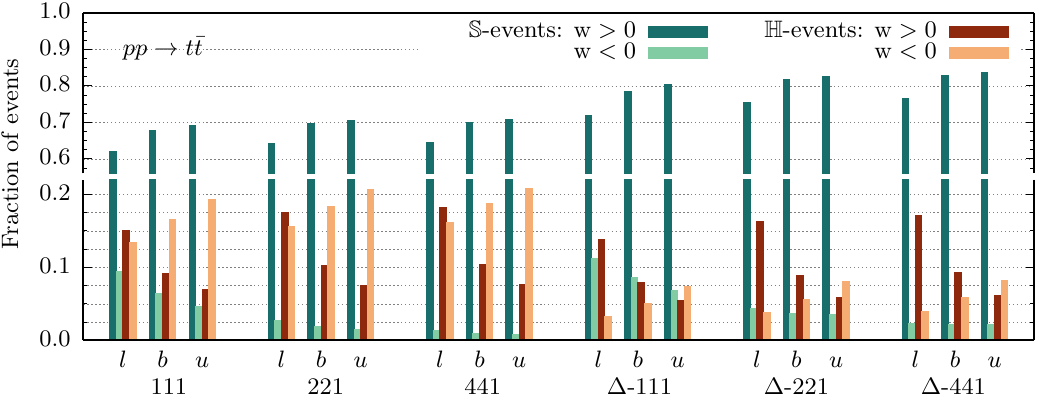
Figure 10 . Fractions of positive- and negative-weight events, for both S and H events, in t (cid:22) t